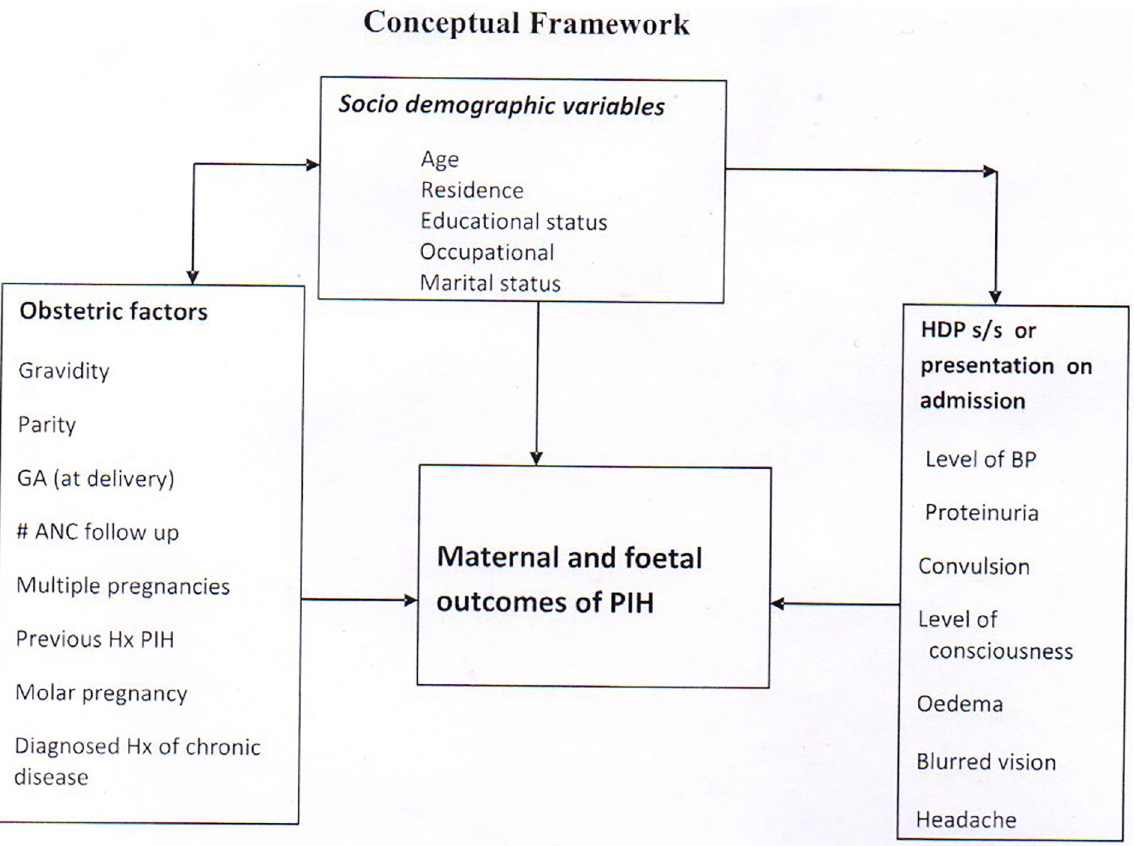
Fig 1. Conceptual frame work of PIH and factors (source from literature review). Legend: PIH: Pregnancy-induced hypertension, HDP: hypertensive disorder of pregnancy, Hx: history, ANC: antenatal care, GA: gestational age.